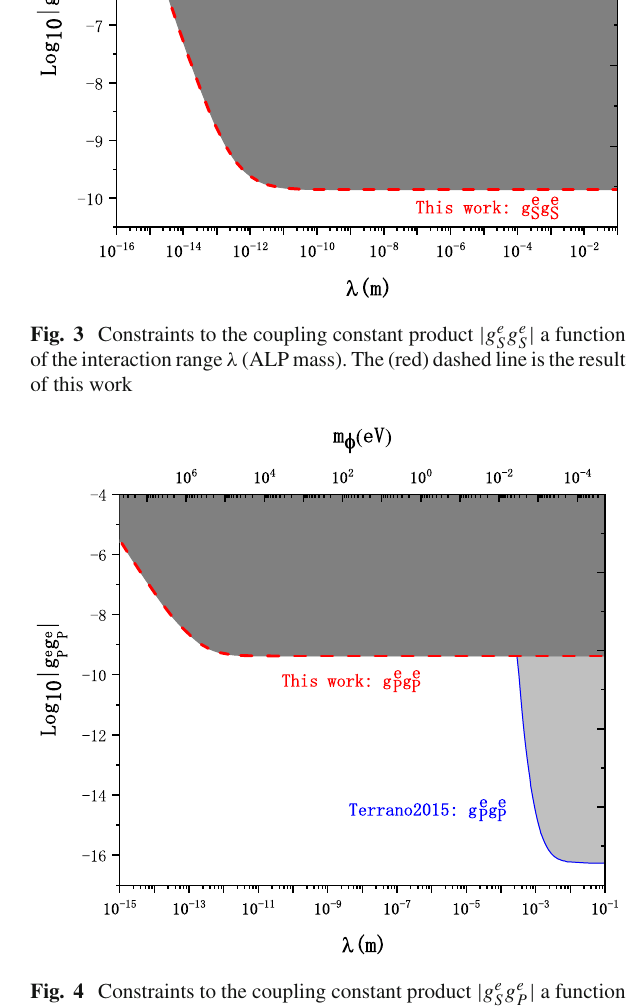
Fig. 4 Constraints to the coupling constant product | g e of the interaction range λ (ALP mass). The (red) dashed line is the result of this work. The (blue) solid line is the result of Ref. [3]. The dark grey area is excluded by this work and grey area is excluded by Ref.